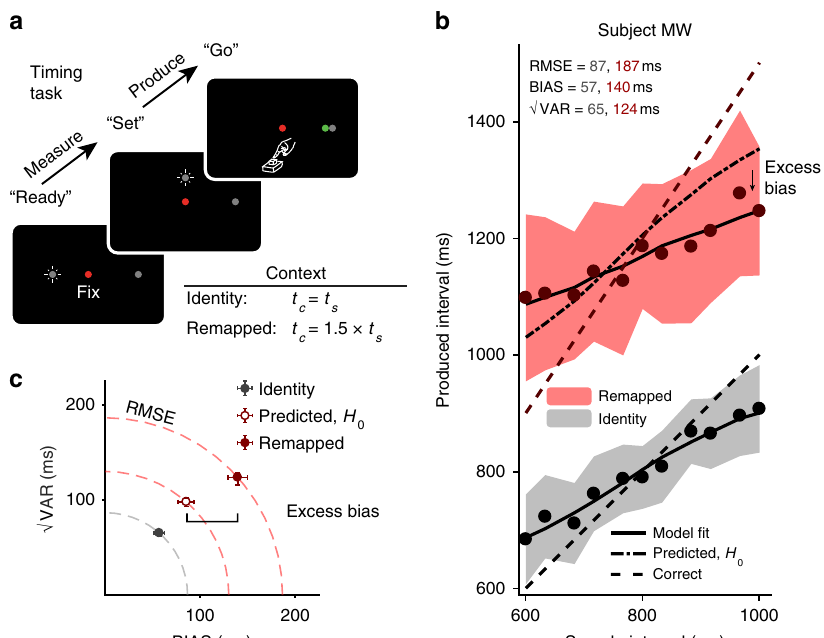
Fig. 2 Time measurement and production task, gain = 1 and 1.5. a Trial structure. Each trial began with the presentation of a red fi xation spot and a gray “ Go target ” . Subjects had to measure a sample time interval t s demarcated by two fl ashes ( “ Ready ” and “ Set ” ). After Set, subjects had to press a key ( “ Go ” ) to produce an interval as close as possible to the correct interval t c = gain × t s . In the “ identity ” context, the correct interval was the same as t s (gain = 1), whereas in the “ remapped ” context, the gain was 1.5. The ratio between the distances of Go and Ready to the fi xation point was equal to the gain factor. After the response, subjects received feedback via a colored circle, whose position relative to the Go target indicated the magnitude and sign of the error. The color of the circle indicated whether the error was smaller than a fi xed threshold (green for a “ hit, ” white for a “ miss ” ; the example illustrates a hit trial). b Behavior. Produced interval of a representative subject in the identity (gray) and remapped (red) contexts ( fi lled circles: mean, shaded regions: mean ± one standard deviation; dashed line: correct intervals). Solid lines represent the mean responses of a Bayesian observer-actor model (see Methods) fi t to the subject ’ s data separately for the two contexts; the dash-dot line in the gain = 1.5 condition corresponds to the prediction for the remapped context under the null hypothesis, using parameters of the model fi t to the identity context ( H 0 : no additional MTN). The subject ’ s behavior shows excess bias beyond what was predicted assuming no additional MTN. c √ VAR vs. BIAS for the two contexts (gray: identity, dark red: remapped), as well as the prediction for the remapped context assuming no additional MTN (empty circle). This prediction underestimates RMSE indicating larger MTN for the remapped context. A substantial portion of increased RMSE was due to an increase in BIAS ( “ excess bias ” ). Dashed quarter circles illustrate combinations of BIAS vs. √ VAR giving rise to equal RMSE; error bars represent 95% con fi dence intervals estimated using a bootstrap procedure ( n = 1000)